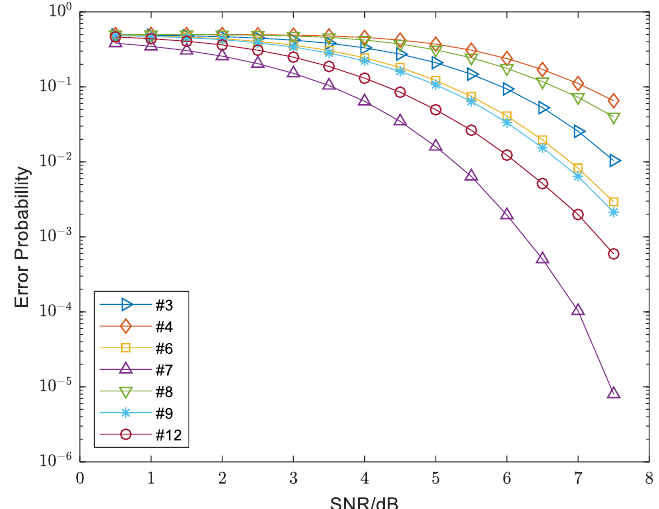
Figure 4. Error probability of sub-channels (3,4,6,7,8,9,12) in strong turbulence.